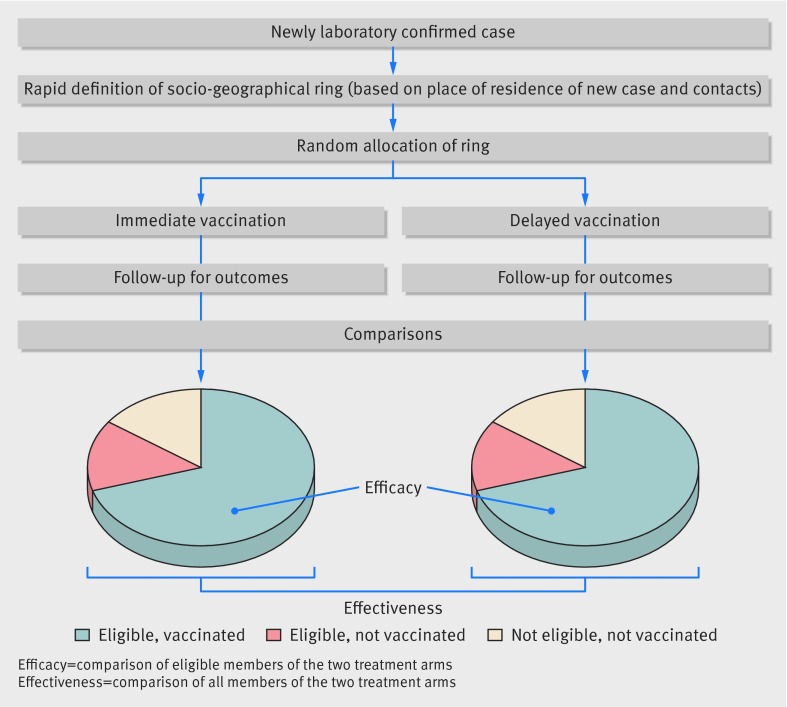
Fig 2 Schematic presentation of the design of a ring vaccination trial during an outbreak of an infectious disease